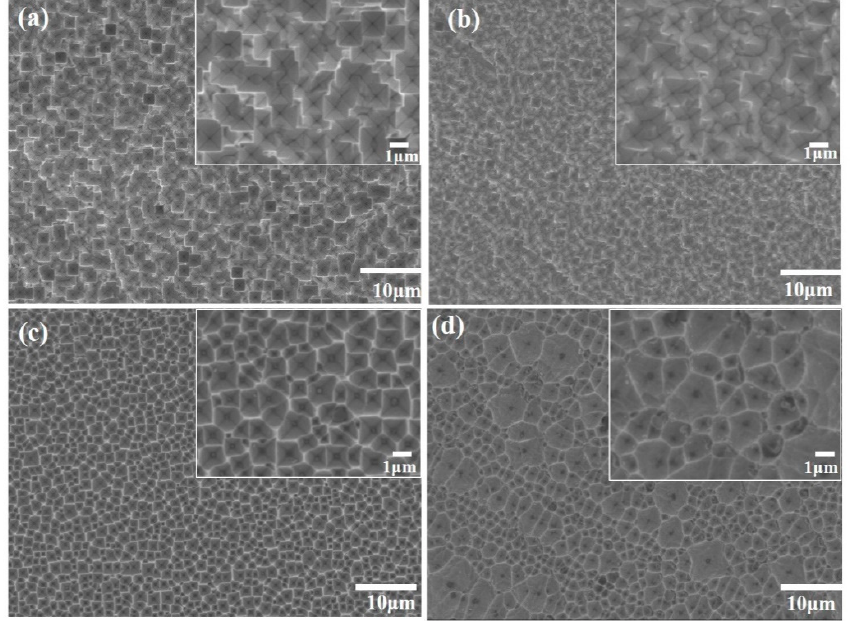
Figure 12. SEM images of uniform inverted pyramid structure fabricated by NSR technology ( a ) and Ag@PVP–ACE ( b ) and the morphology transformation with increasing etching time in NSR process ( c ) and Ag@PVP–ACE process ( d ). ( c ) and Ag@PVP–ACE process ( d